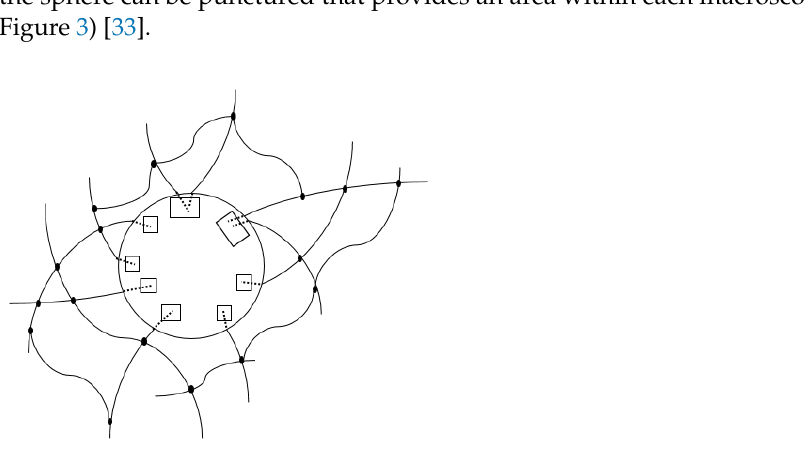
Figure 3. The black hole entropy through puncture in the surface of the event horizon. The rectangles show micro